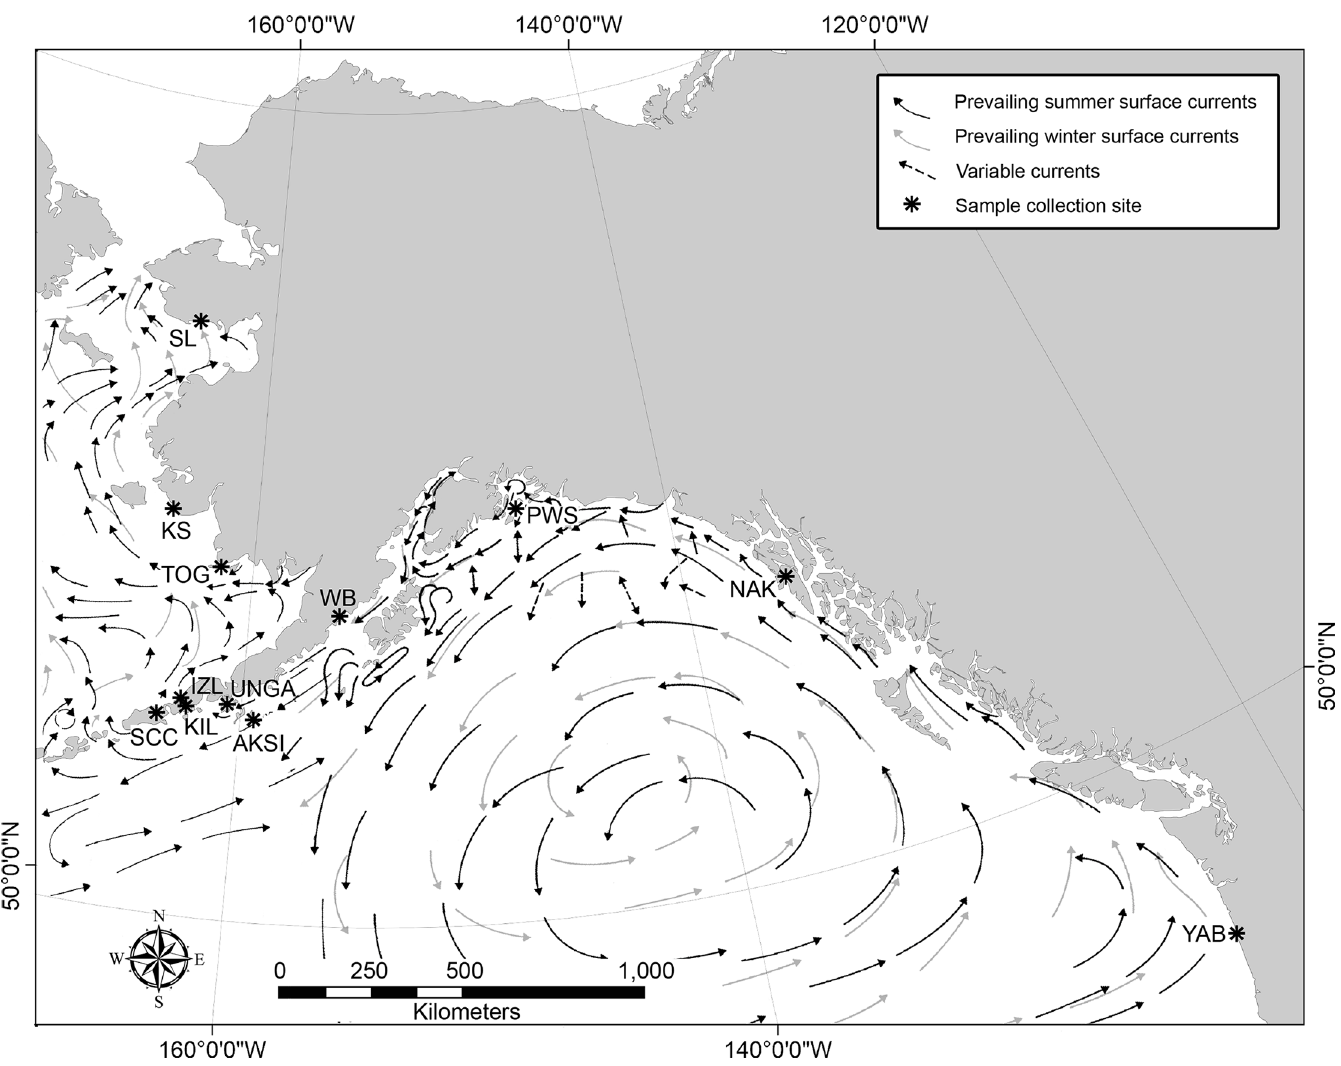
Fig 2. Sites sampled for Z . marina analyzed in this study, with respect to surface currents. Sample locales for Z . marina are shown with asterisks ( * ). Arrows indicate direction of prevailing seasonal surface currents derived from Brower et al. [53,54]. The base map was produced using ArcGIS version 10.2.2